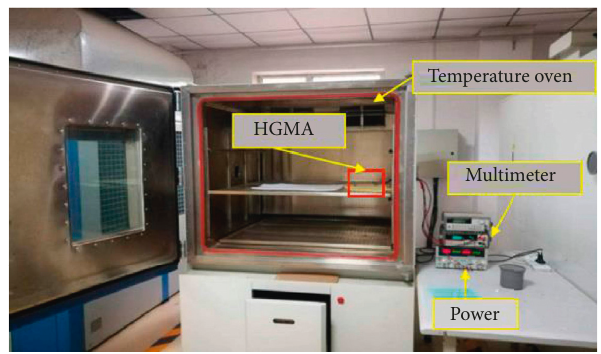
Figure 8: Temperature measuring equipment.